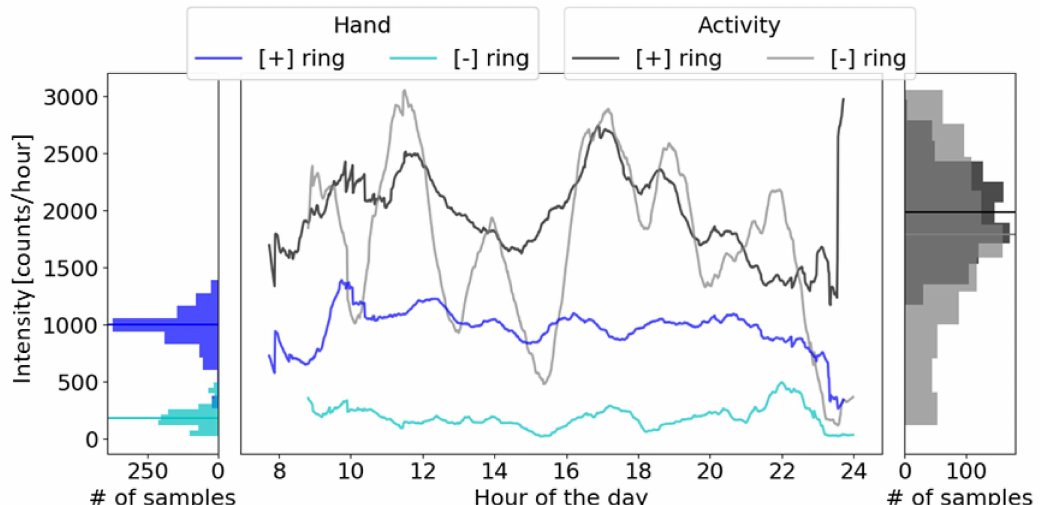
Figure 9. Effect of environmental magnetic noise on HAND counts. Data is from one subject with a stroke (BBT score = 40) who used the Manumeter for 21 days. The subject wore the Manumeter without the magnetic ring ([ − ] ring) for 6 of the 21 days and with the ring ([+] ring) for the remainder of the days. The HAND counts and UE activity counts (derived from the wrist accelerometer in the Manumeter wristband) were smoothed using a 1-h running window average and are presented in the middle plot as the average across the days with and without the ring. The left and right plots show the distribution of hand and activity counts per hour with a line representing the average intensity. Note that HAND counts dropped to ~200 counts/hour when the ring was not worn, compared to ~1000 counts/hour when the ring was worn (left distributions, mean bars). Activity counts measured with wrist acceleration stayed about the same on average (right distributions, mean bars), whether the ring was worn or not, as expected. The ~200 HAND counts/hour measured without the ring are due to environmental magnetic